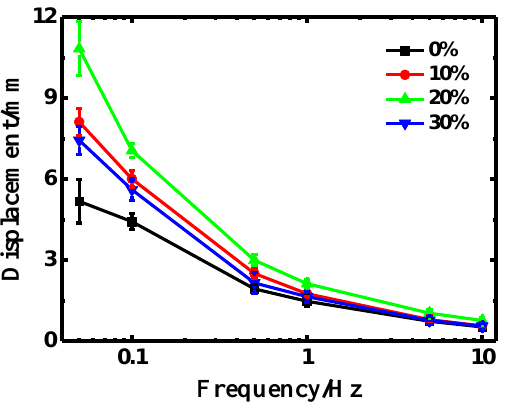
Figure 6. Amplitude − frequency response of PEO/Nafion − IPMC with varying PEO contents. Figure 6. Amplitude-frequency response of PEO/Nafion-IPMC with varying PEO contents. Figure 6 exhibits amplitude-frequency response of the deformation of the The peak − to − peak blocking forces of the IPMCs with PEO contents of 0 wt%, 10 wt%,